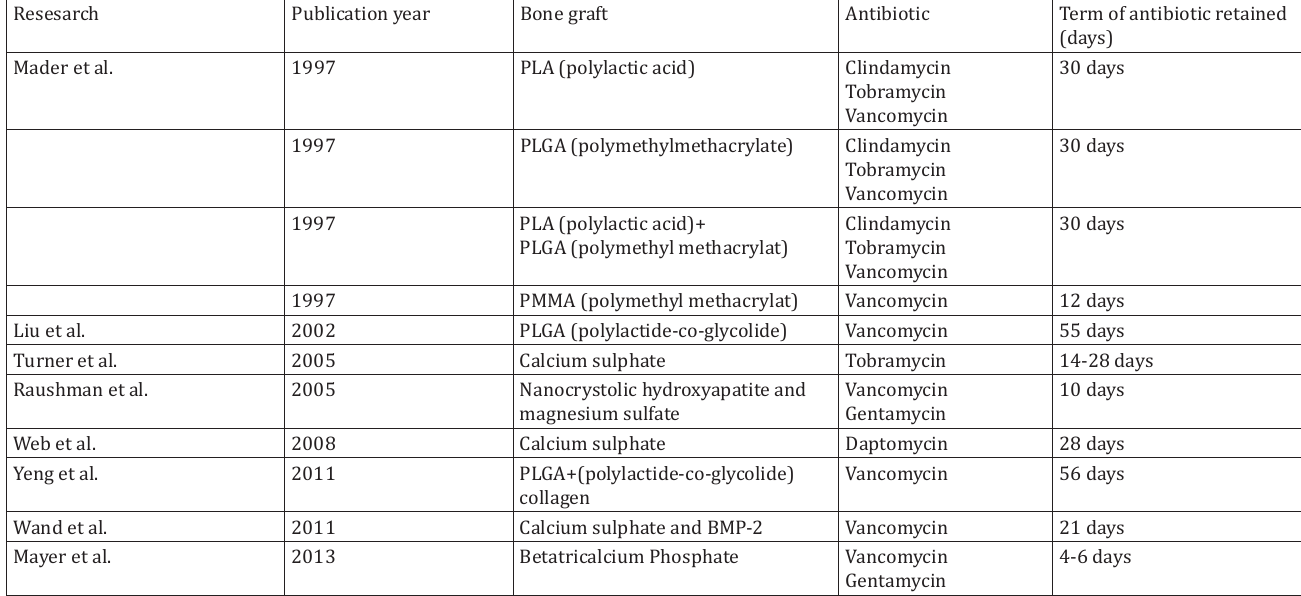
Comparison of local antibiotic transport